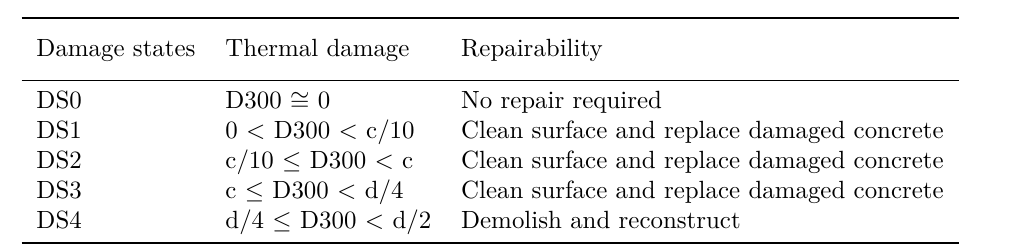
Table 4. Thermal damage states, with c the concrete cover and d the thickness of the cross-section.